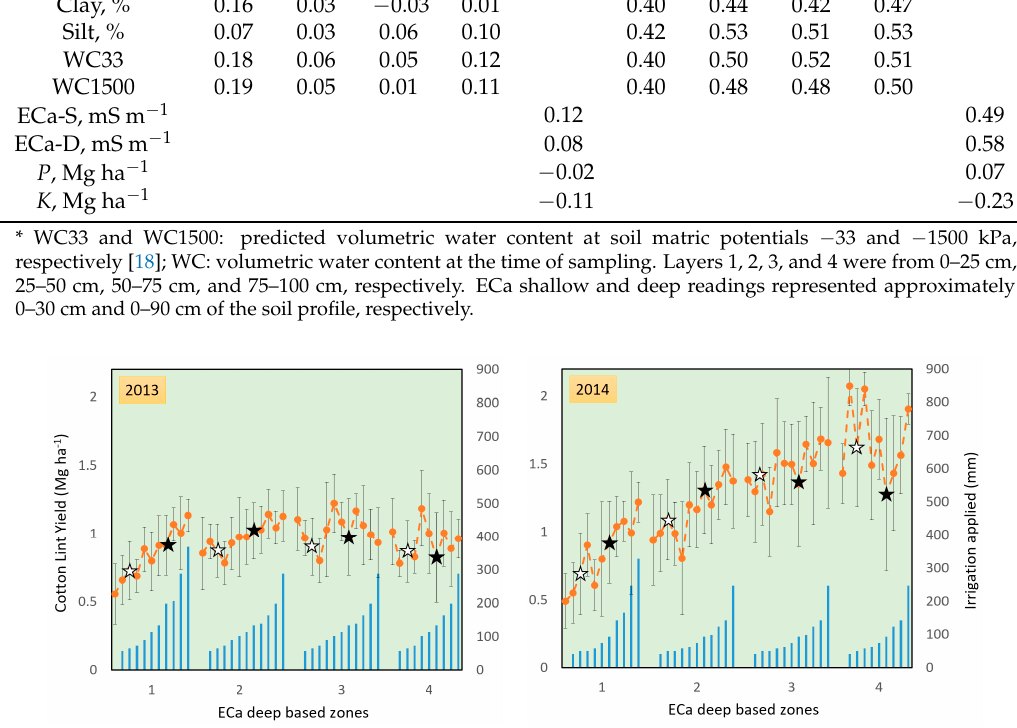
Figure 6. The effects of supplemental irrigation (blue bars, right-hand y -axis) on cotton lint yield (orange lines, left-hand y -axis) in 2013 and 2014 within a 73-ha two-pivot field in west Tennessee. The white and black five-point start symbols denote actual irrigation applications by the farmer for the west and east pivots, respectively. The deep ECa data were used to group cotton lint yield information into four zones, where ECa increases from zone 1 to zone 4, zone 1: 2–8 mS m − 1 , zone 2: 8–18 mS m − 1 , zone 3: 18–35 mS m − 1 , and zone 4: 35–162 mS m − 1 .